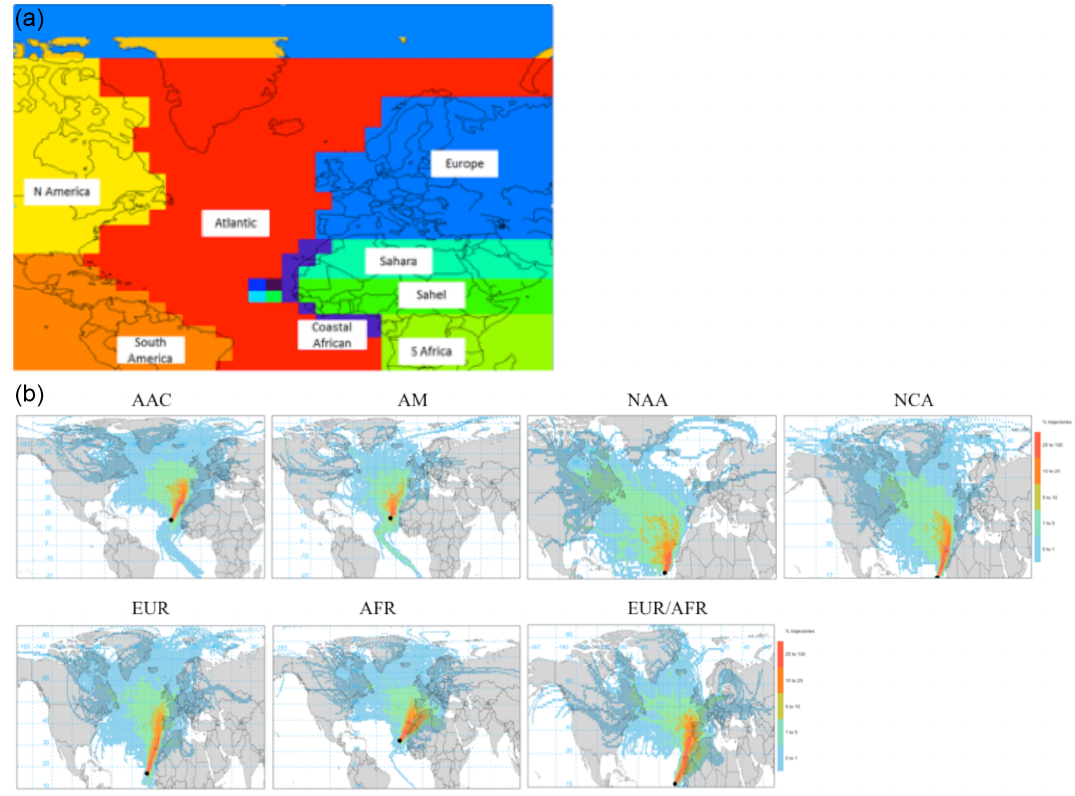
Figure 5. (a) Boundary definition of the eight geographical regions: Coastal African, Europe, Sahara, Sahel, North America, Atlantic, South America, and South Africa. (b) Trajectory frequency maps for each of the seven air mass types using HYSPLIT trajectories and Openair: AAC – Atlantic and African coastal; AM – Atlantic marine; NAA – North American and Atlantic; NCA – North American and coastal African; EUR – European (with minimal African influence); AFR – African (with minimal European influence); and EUR/AFR – European and African.